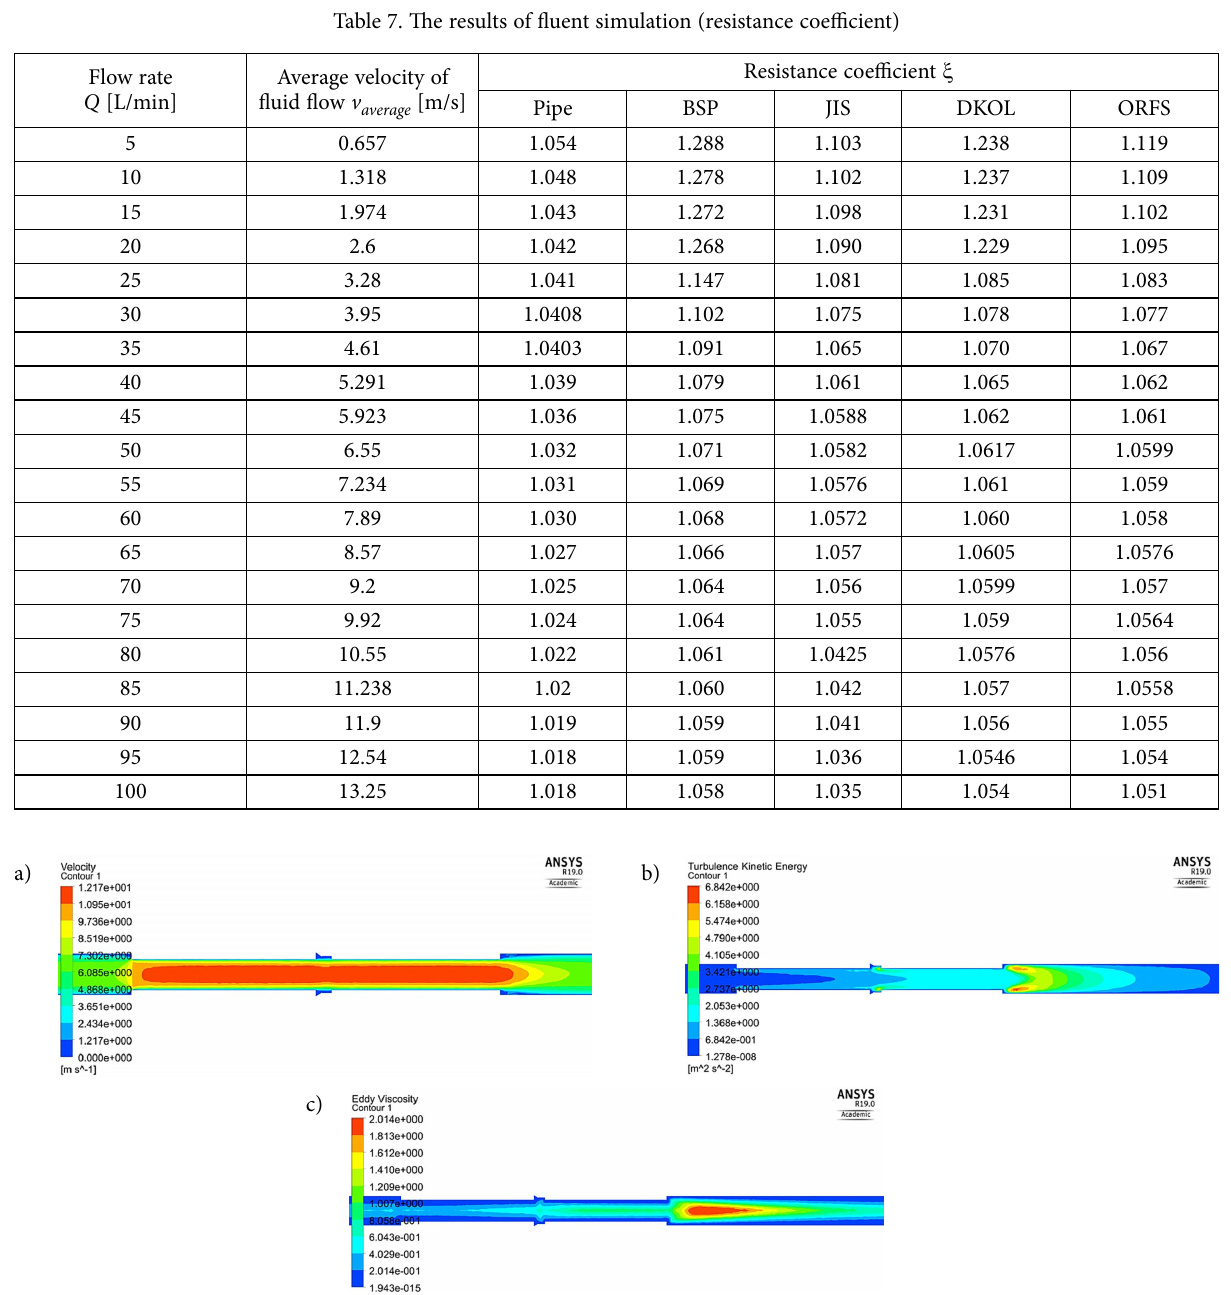
Figure 11. Additional results from the fluent simulation of the DKOL fitting connection: a – velocity;